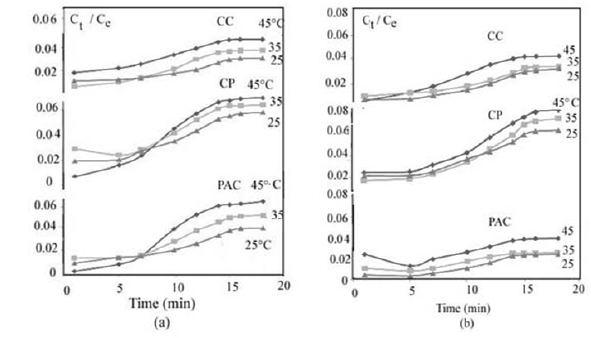
Figure 4. Desorption profiles of (a) AR 183 and (b) AR114 onto adsorbents (C